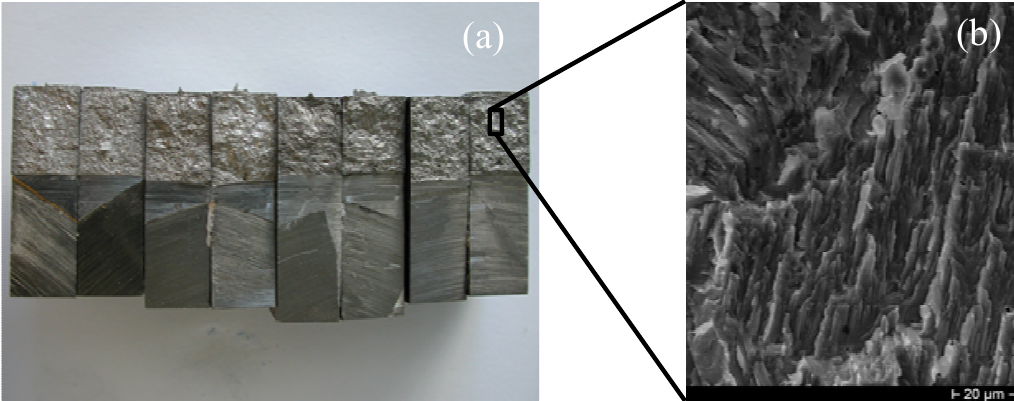
Figure 6: Macrograph showing the fracture surfaces (a) and SEM micrograph showing the fracture surface morphology (b).